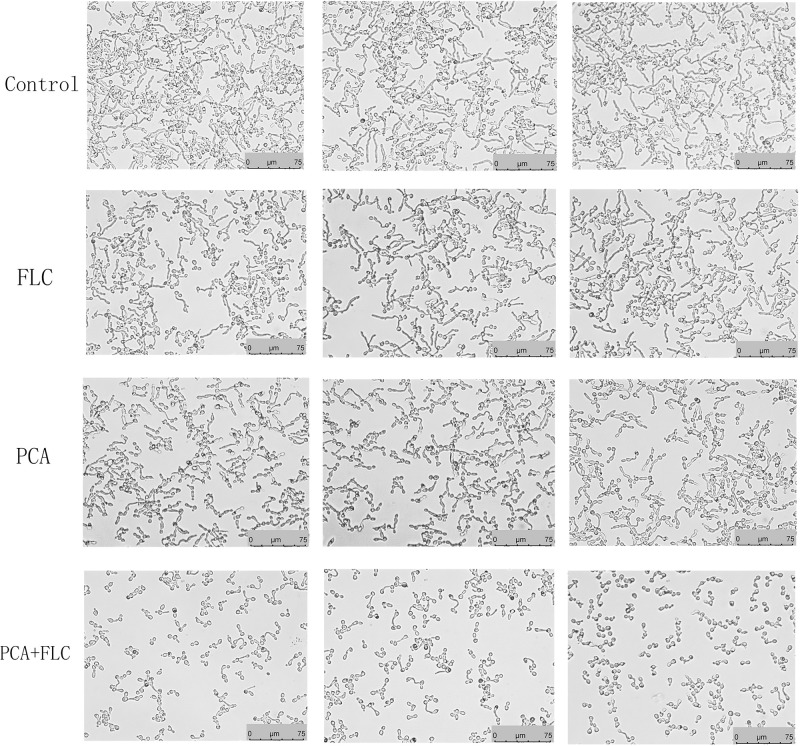
Effect of D-penicillamine (PCA) on Candida albicans hyphal growth. PCA and fluconazole (FLC) were diluted in hyphae-inducing media, RPMI 1640 medium, at a final concentration of 64 and 1 μg/ml, respectively. The cellular morphology was photographed after incubation at 37°C for 4 h. The photographs were collected from three independent experiments.